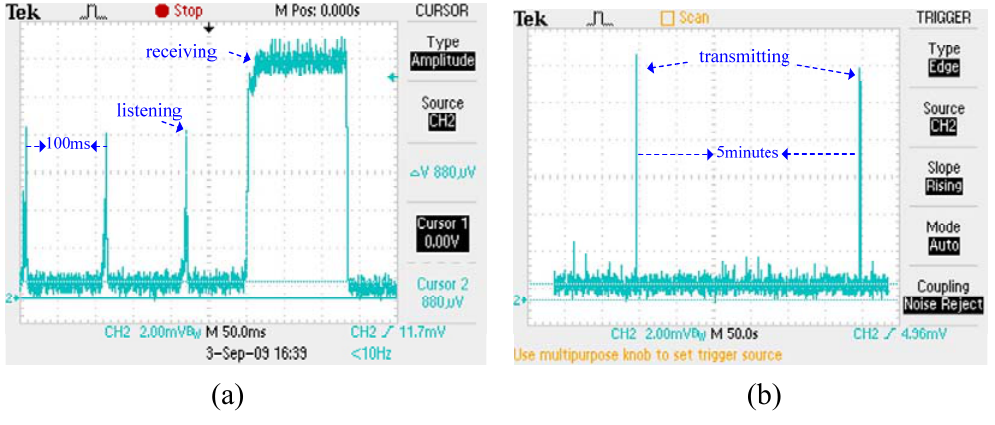
Figure 16. (a) Power consumption of master node. (b) Power consumption of slave